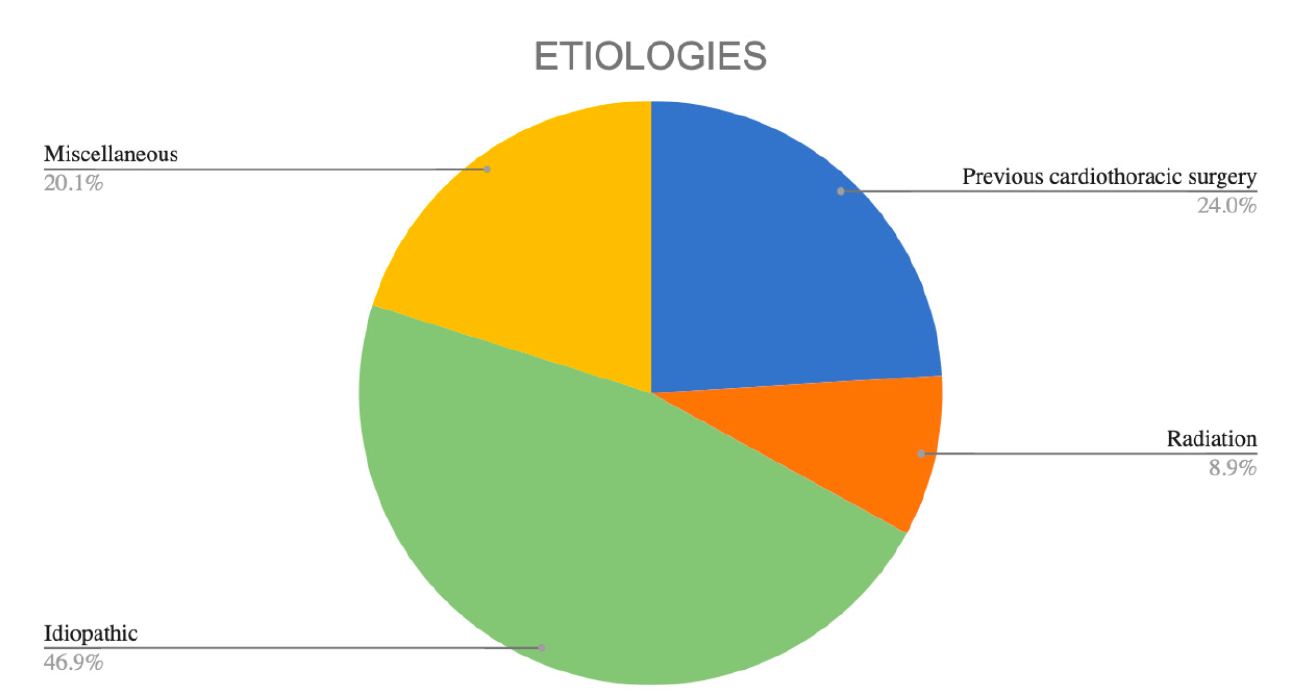
Fig. 1 - Etiologic classification of constrictive